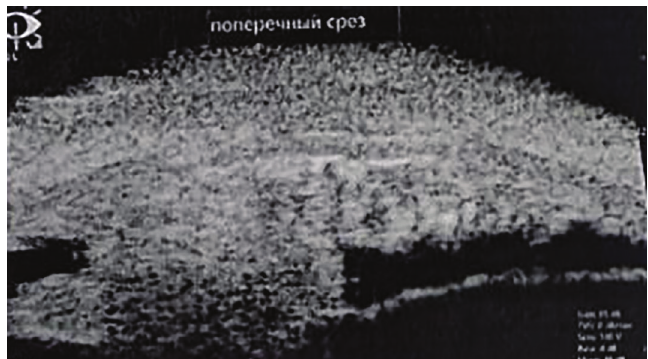
Figure 4 - Ultrasonic biomicroscopy picture in the area of